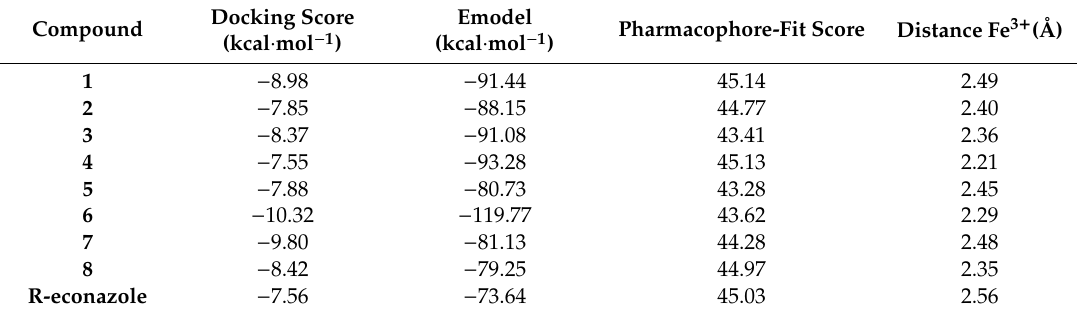
Table 4. Docking Score and Emodel energy contributions, Pharmacophore-Fit score values, and distance from the heme ferric iron atom of the selected compounds and the known inhibitor R-econazole.